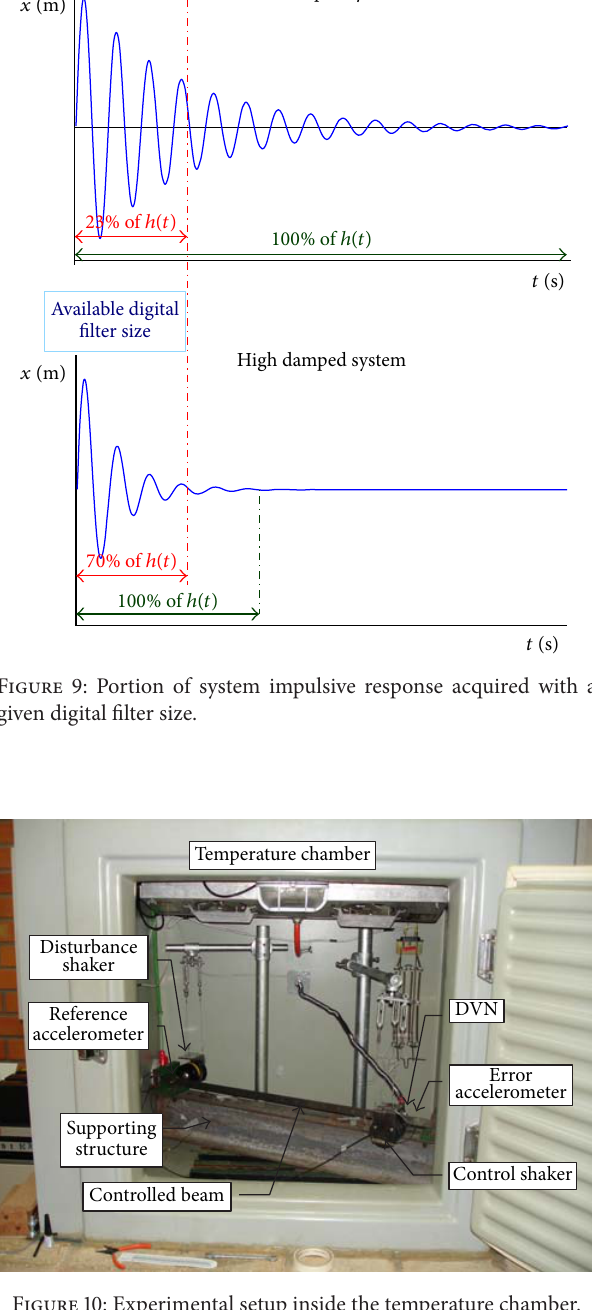
Figure 10: Experimental setup inside the temperature